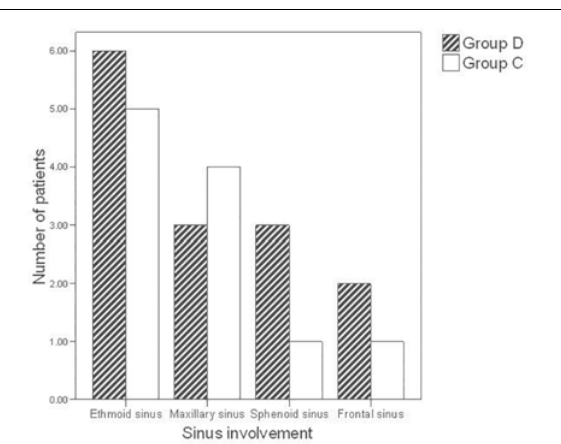
Bar chart for causative fungi among groups. * P < 0.05, signi (cid:383) cant difference between groups. Group D = L -alanyl- L -glutamine group; group C = control group